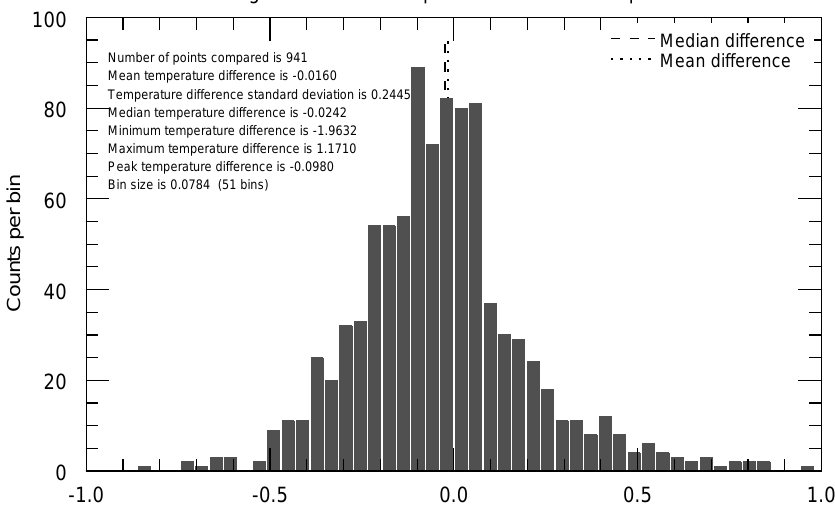
Figure 9. Differences between 1min average radiosonde temperatures and 1min values of temperatures from the HMP45C when the ra- diosonde was co-located with the Kiritimati surface instruments prior to launch. All available good surface data and the corresponding radiosonde data (101 radiosondes) are